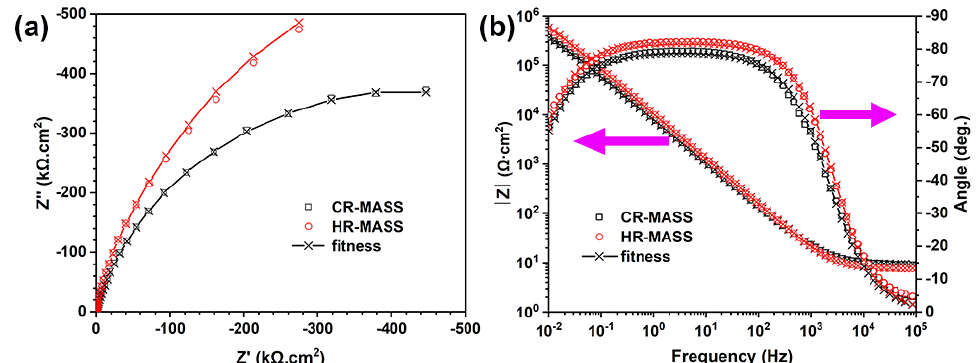
Figure 6. EIS spectrum of the experimental MASS in 3.5 wt.% NaCl aqueous solution at room temperature (~25 °C): ( a ) Nyquist plots, ( b ) Bode plots.